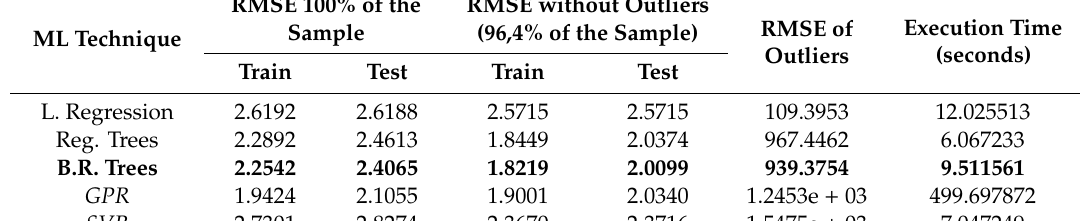
Table 18. SSDE-CTDI VOL results for Abdomen protocol.